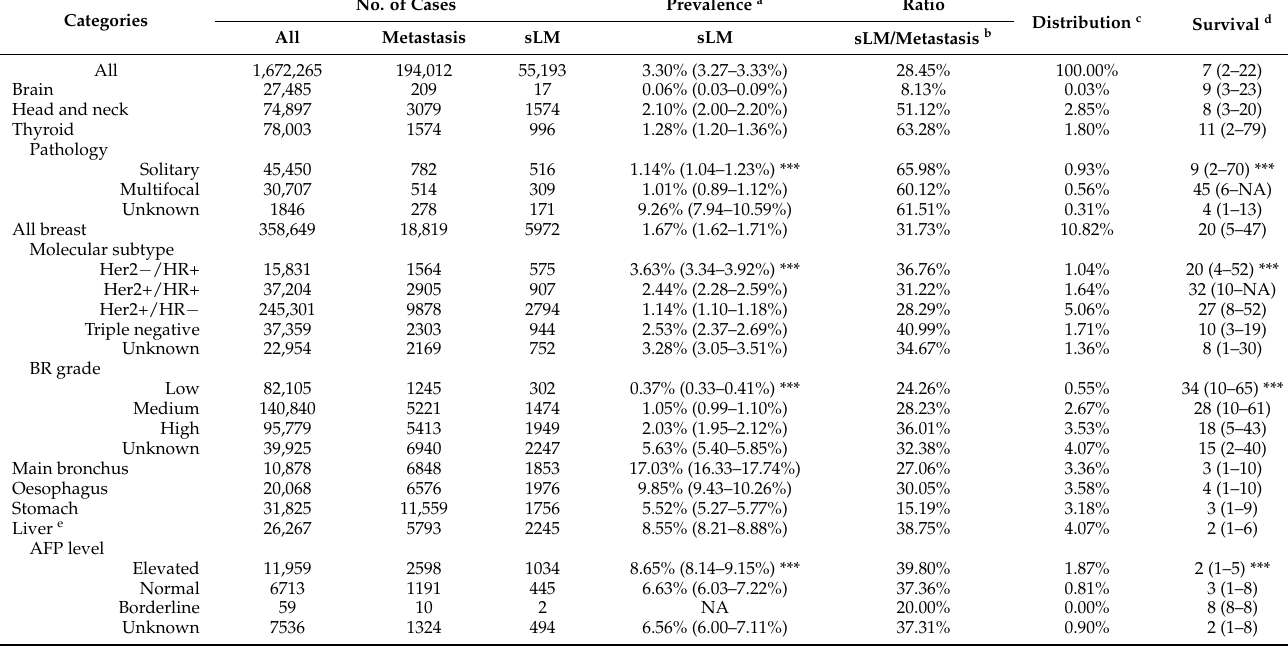
Table 1. The number of all cases, metastatic cases, and cases with synchronous lung metastasis and their corresponding prevalence, distribution, and median survival with interquartile range by cancer